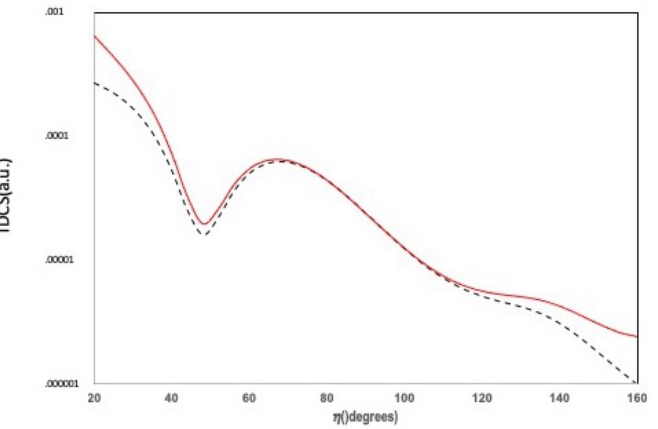
Figure 8. TDCS for the positron impact ionization of hydrogen in energy sharing geometry, E 0 = 100 eV, Φ = 56.13 ◦ . DWBA:solid red DWBA + N e + e − : dashed